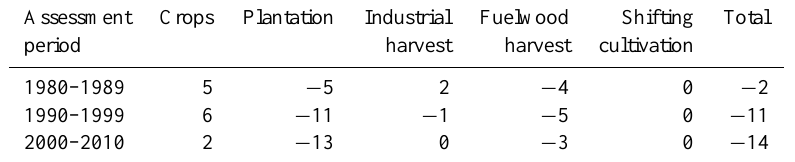
Table 2. Net emissions ( + ) and accumulations ( − ) of carbon (TgCyr − 1 ) attributed to different types of land use in South Asia. Assessment Crops Plantation Industrial Fuelwood Shifting Total period harvest harvest